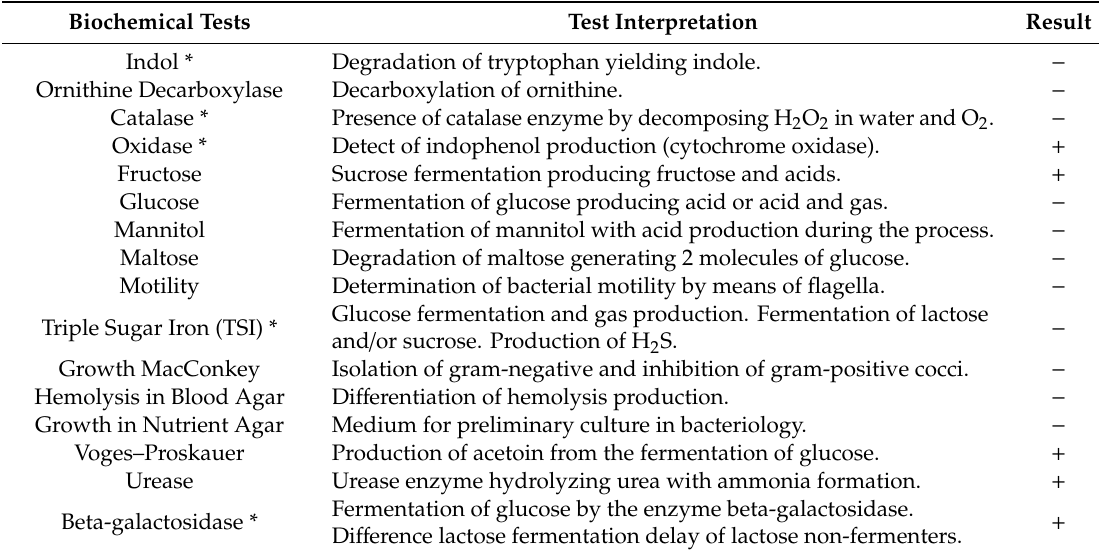
Table 1. Phenotypic profile of Ornithobacterium rhinotracheale (ORT). Biochemical Tests Test Interpretation